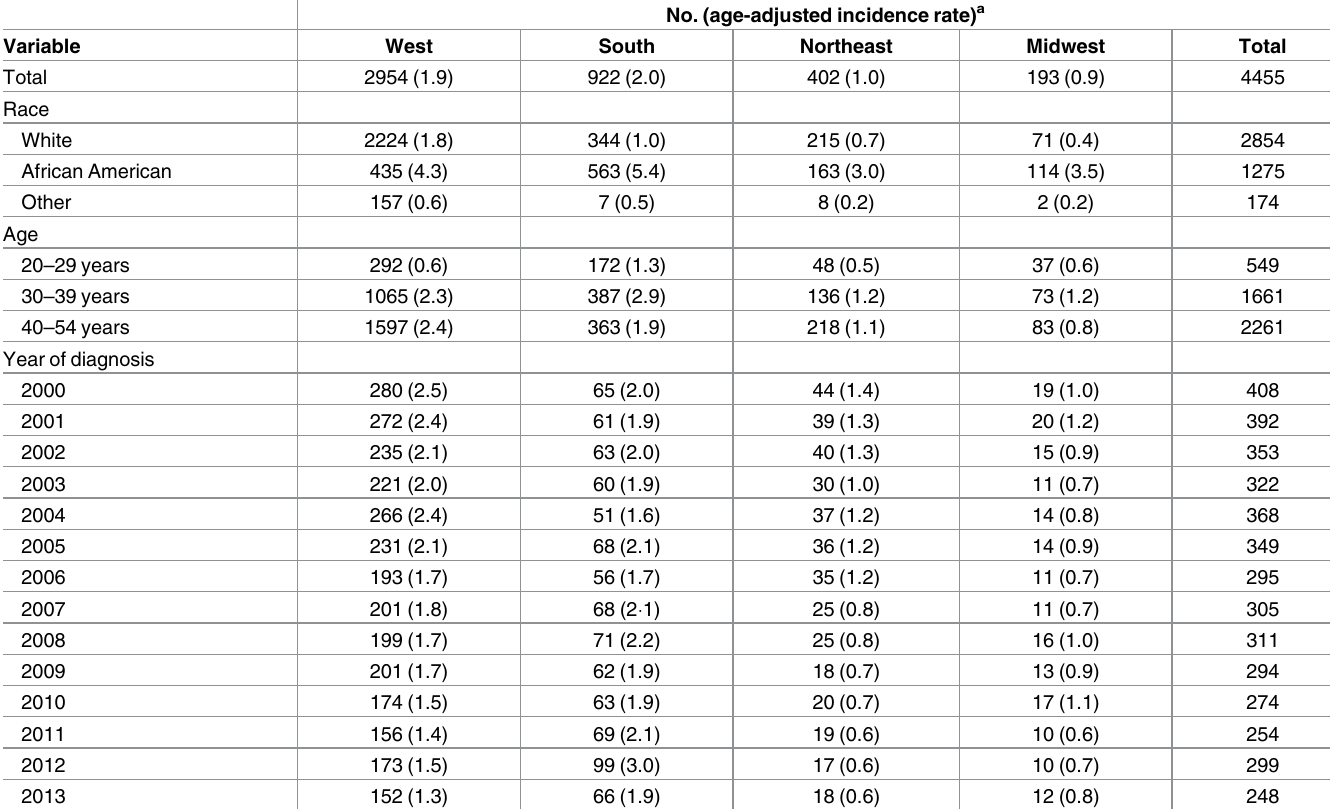
Table 1. Number of Kaposi sarcomacases and incidence rates by U.S. region: 2000–2013.